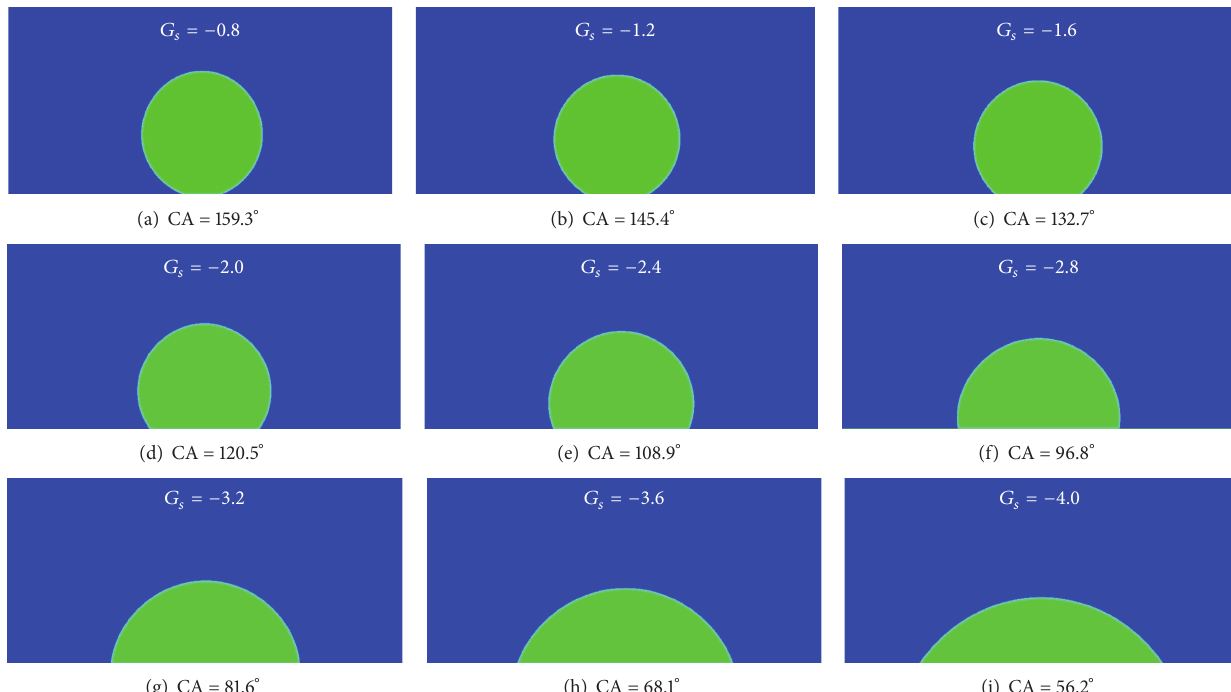
Figure 1: Droplet shape and intrinsic contact angle of smooth surfaces under different adsorption parameter.